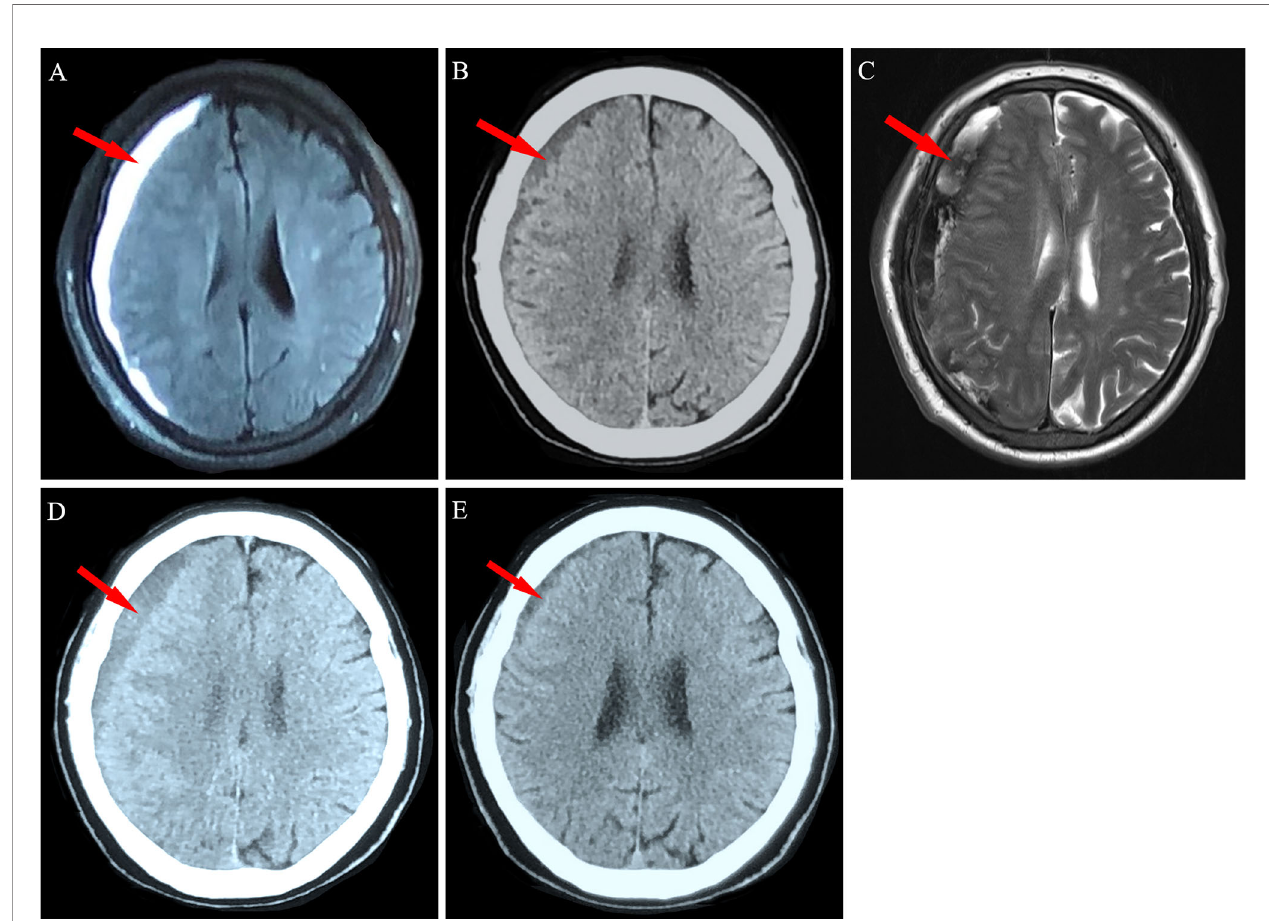
FIGURE 3 | Neuroimaging fi ndings for Patient 2. (A) A 72-year-old man with chronic myeloid leukemia was diagnosed as having right frontotemporal chronic subdural hematoma (red arrow). (B) The hematoma was signi fi cantly absorbed after 2 weeks of conservative treatment. (C) New bleeding in the subdural space was detected via magnetic resonance imaging at the 4-week follow-up. (D) Obvious absorption was observed after 10 weeks and (E) near disappearance was observed after 20 weeks of conservative